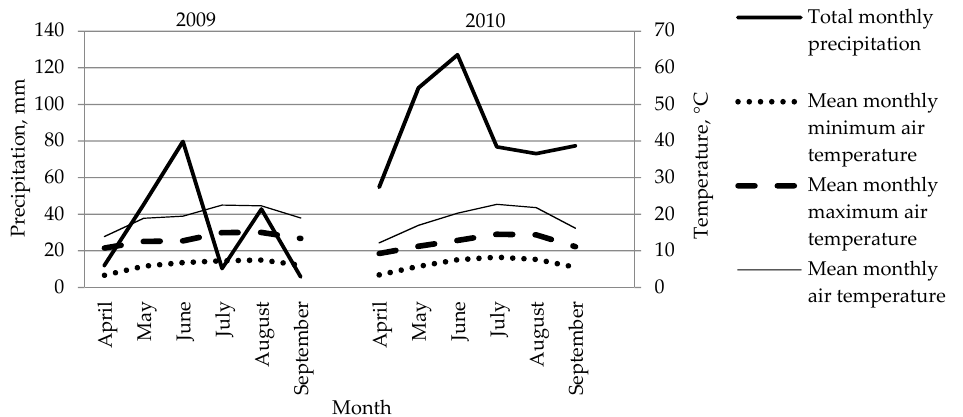
Figure 1. Climate diagram according to Walter and Lieth [17] during the soybeans growing seasons.